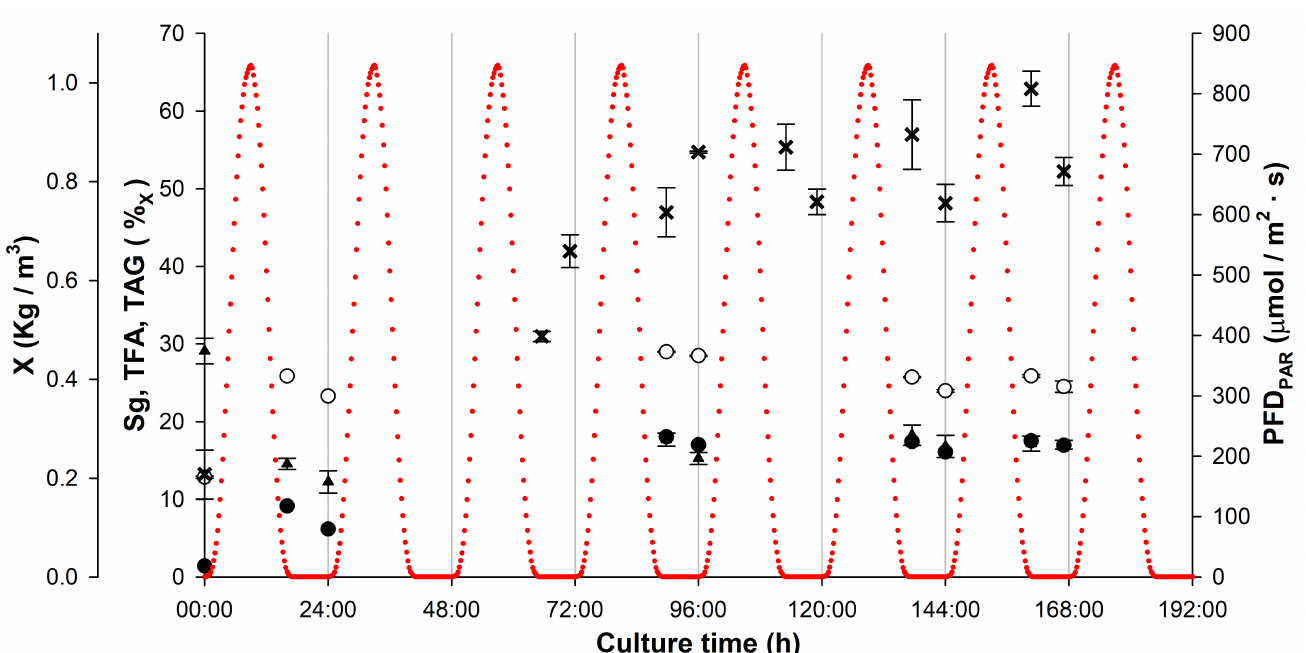
Figure 1. Physiological changes in N. gaditana under day–night cycles in depleted conditions. Triangles represent total carbohydrates; white circles represent total fatty acids; black circles represent tricylglycerol (TAG); red dots represent the photon flux density supplied to the